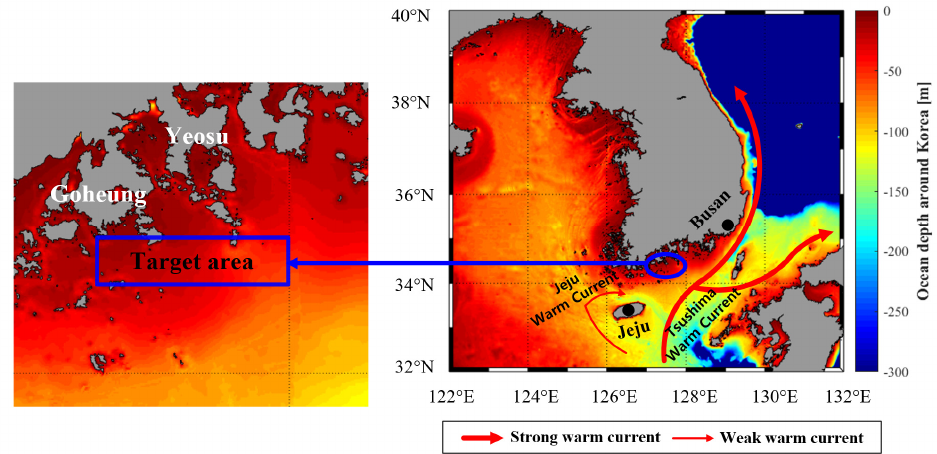
Figure 3. Ocean depth and current flow patterns around Korea.